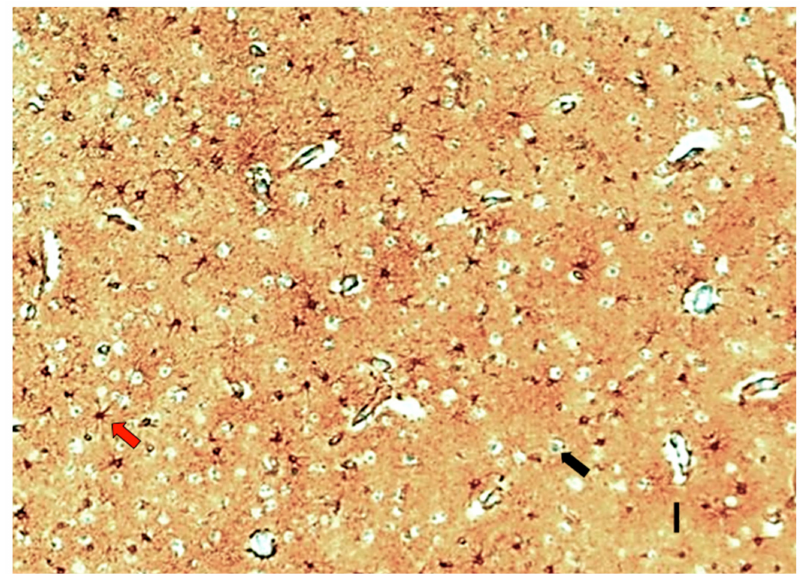
Figure 2. Histological section of the human neocortex (layers 2–3) parallel to the pial surface (scale bar, 50 µ m). Astrocytes (red arrow) were immunolabeled with GFAP (glial fibrillary acidic protein). Body neurons (black arrow) were not labeled. Astroglial matrix is a sponge-like 3D-structure where neurons of the cortex are